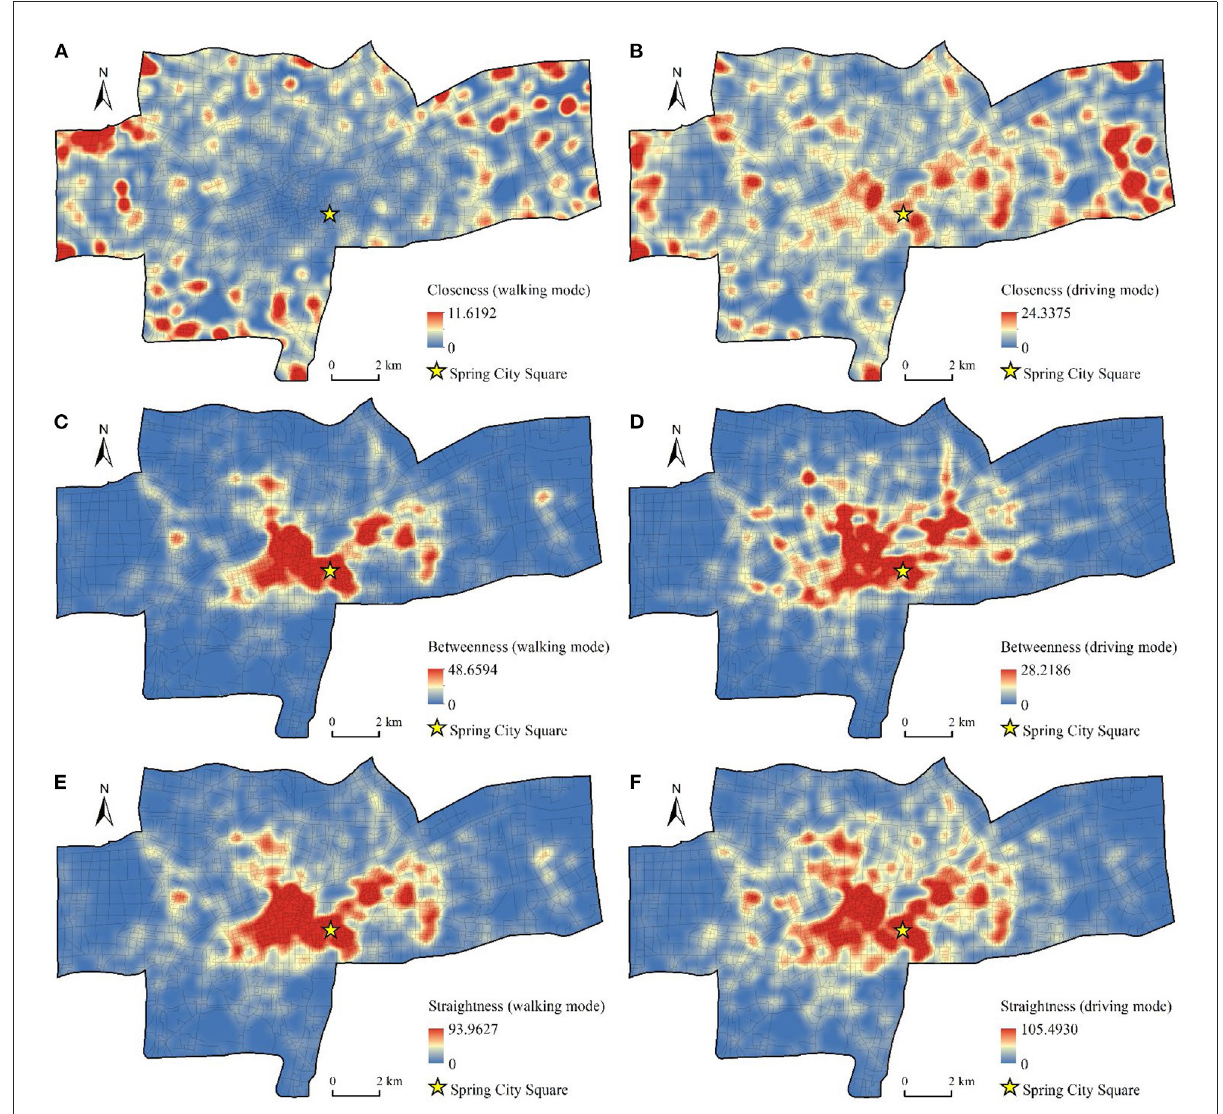
FIGURE4 KDEs of street centrality. (A) Closeness of walking mode. (B) Closeness of driving mode. (C) Betweenness of walking mode. (D) Betweenness of driving mode. (E) Straightness of walking mode. (F) Straightness of driving mode.